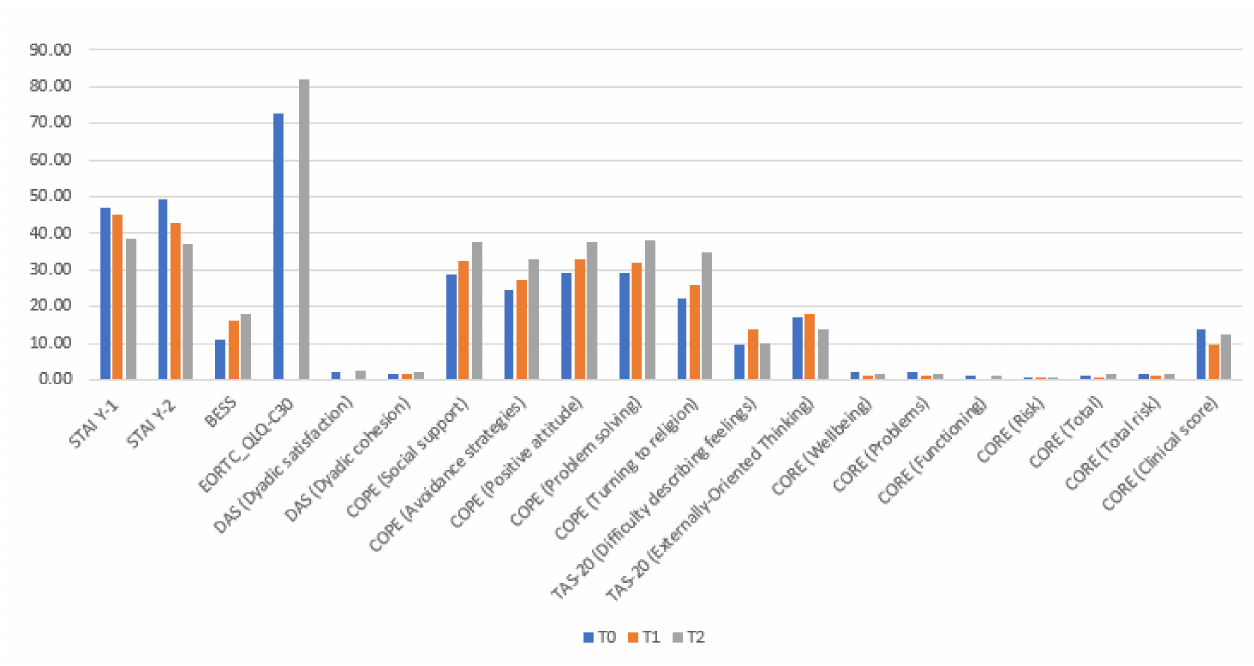
Figure 2. Repeated-Measures ANOVA for T0, T1, T2: significative